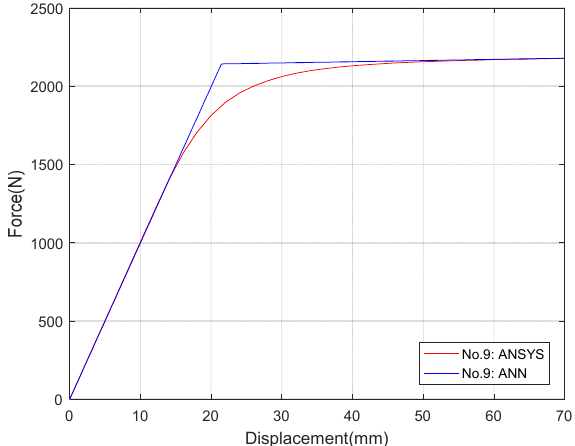
Figure 19. Estimated load–displacement curve (seventh coil damper).